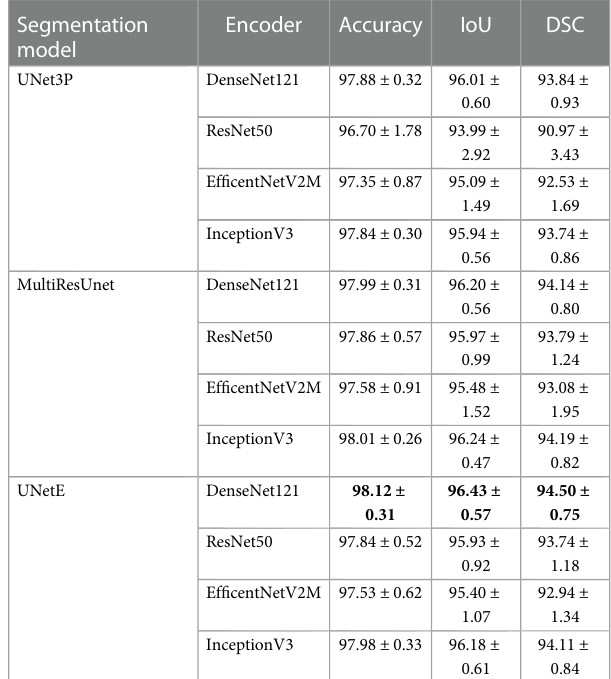
TABLE 4 Angle prediction results and MAE (mean average error) for segmentation